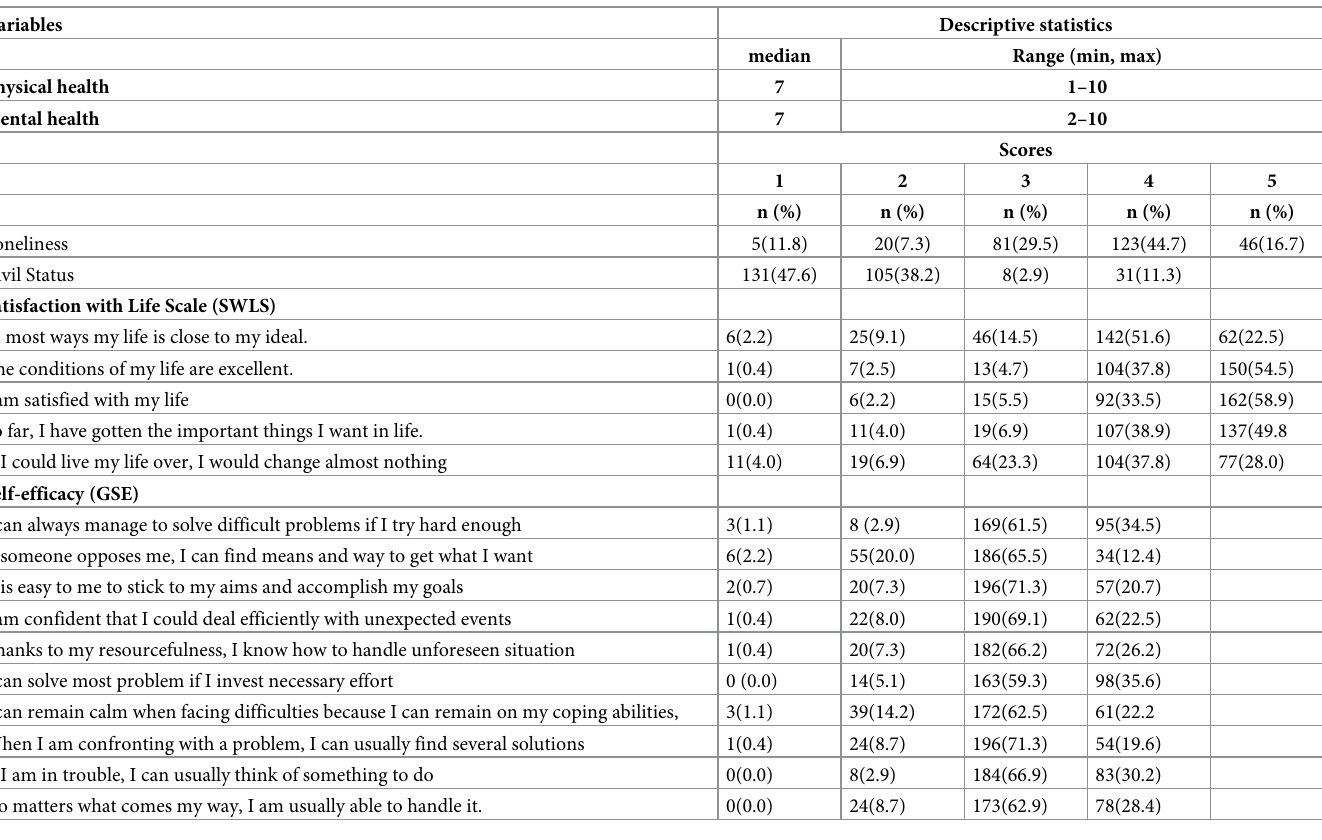
Table 2. Descriptive statistics and scores for selected analysed variables (QOL, civil status, self-efficacy, loneliness, and physical and mental health).